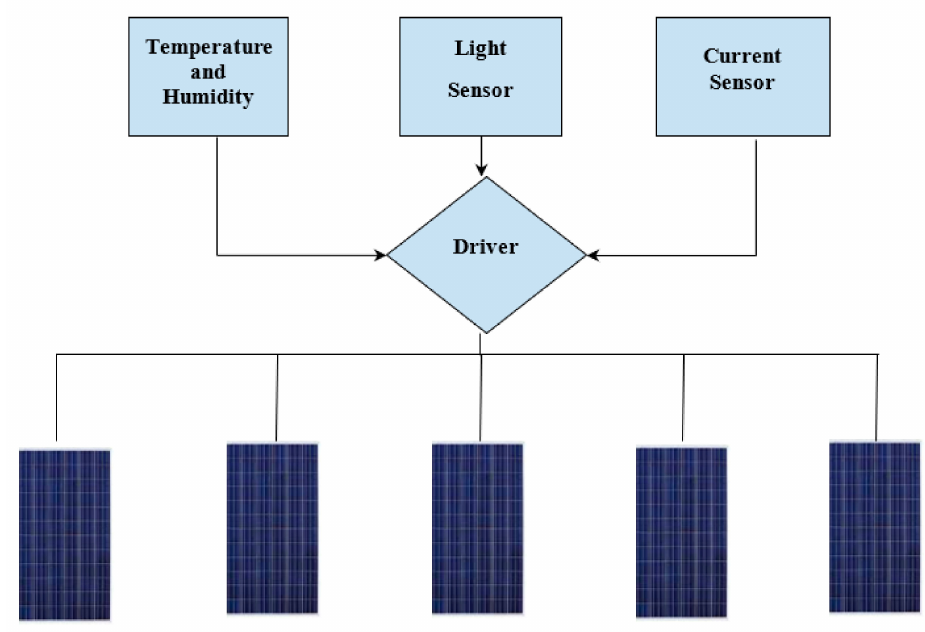
Figure 2. Single-line connection between devices and solar